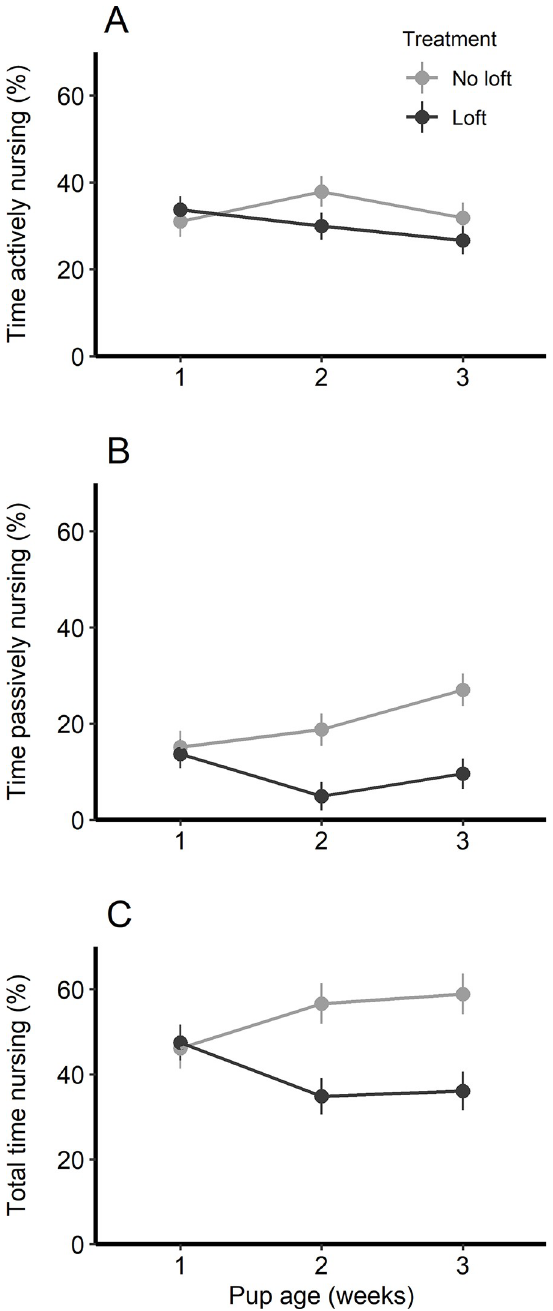
Fig 3. Mean time rats spent nursing per week, shown separately for A) active nursing, B) passive nursing, and C) total nursing. Results are shown separately by treatment, with 9 rats in the loft treatment and 7 rats in the no loft treatment. Plot depicts the LS means and standard errors from the model